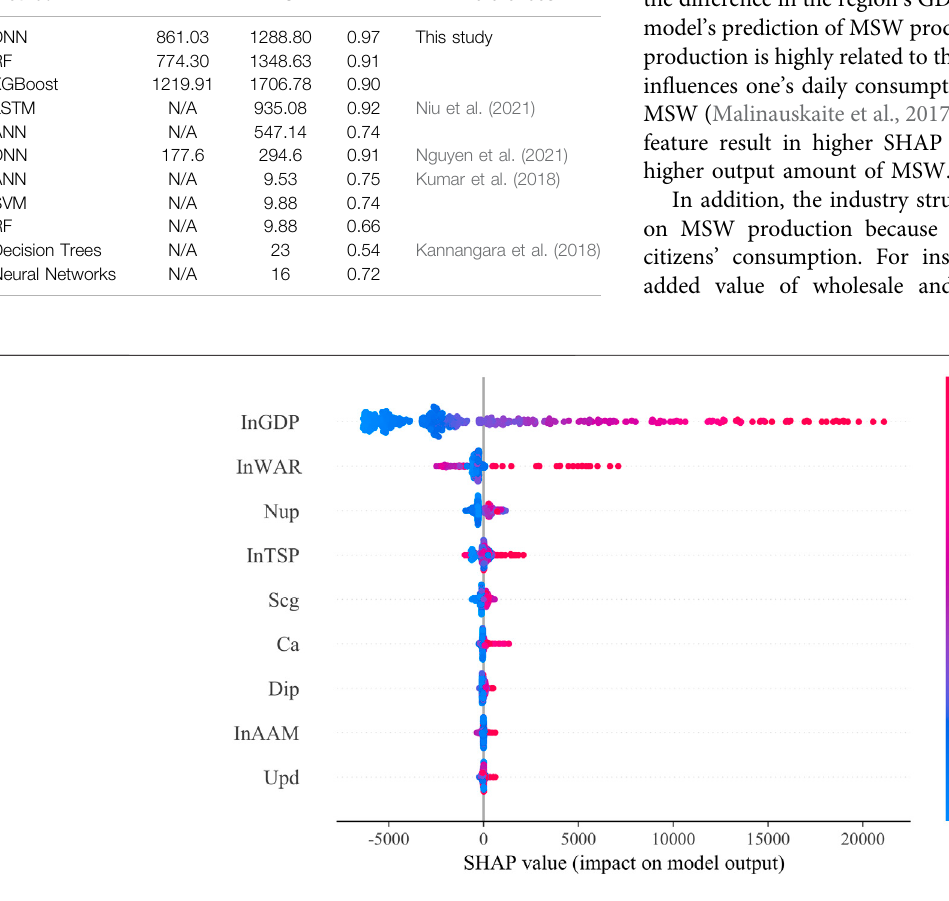
FIGURE 8 | SHAP summary